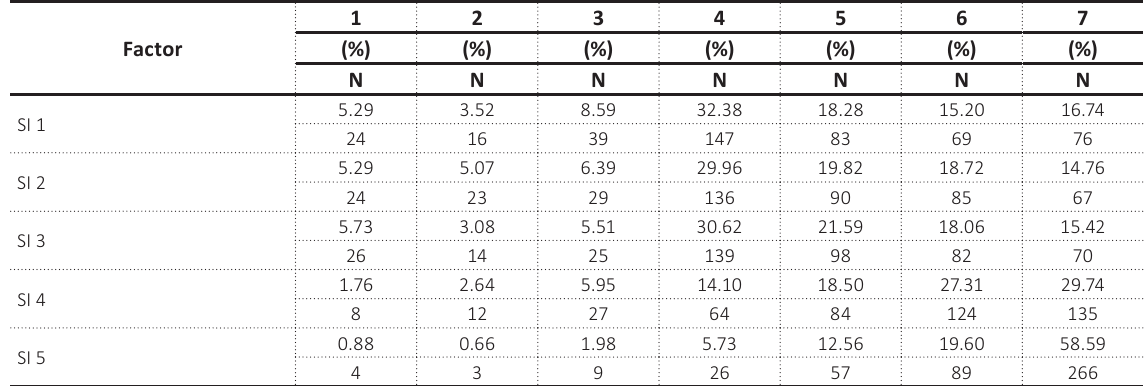
Source: Own processing.